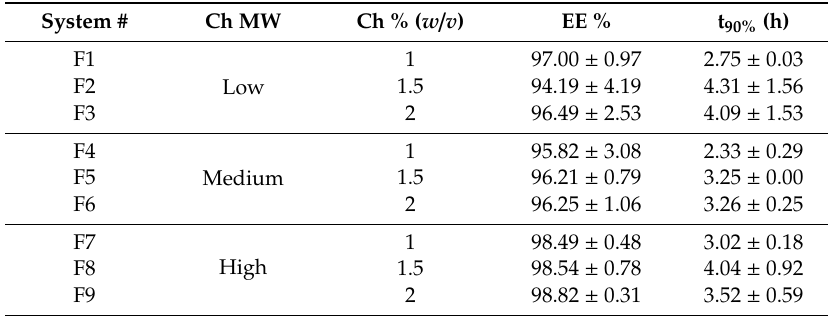
Table 1. Composition of VP-loaded Ch beads, independent variables and measured responses of the 3 2 full factorial experimental